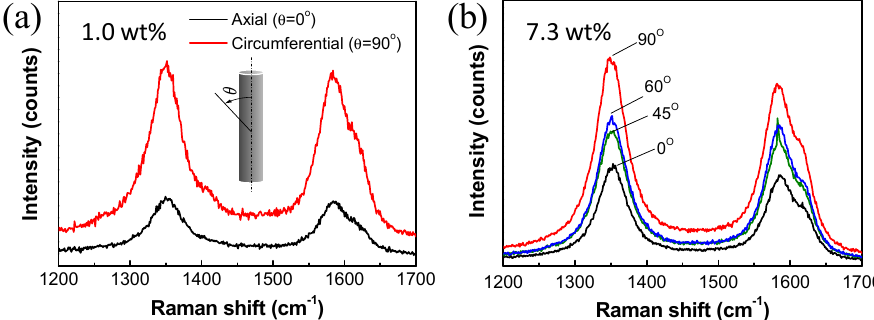
Figure 7. Polarized Raman spectra of MWNT/PDMS composites with MWNT content of ( a ) 1.0 wt%, and ( b ) 7.3 wt%.